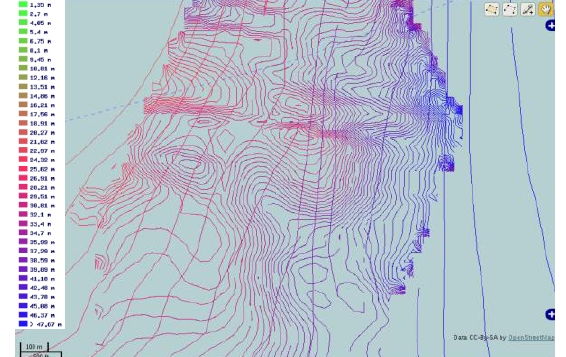
Figure 5. . Levanzo island, Sicily. Contour Lines: Reference (coarse) vs. Computed (fine)